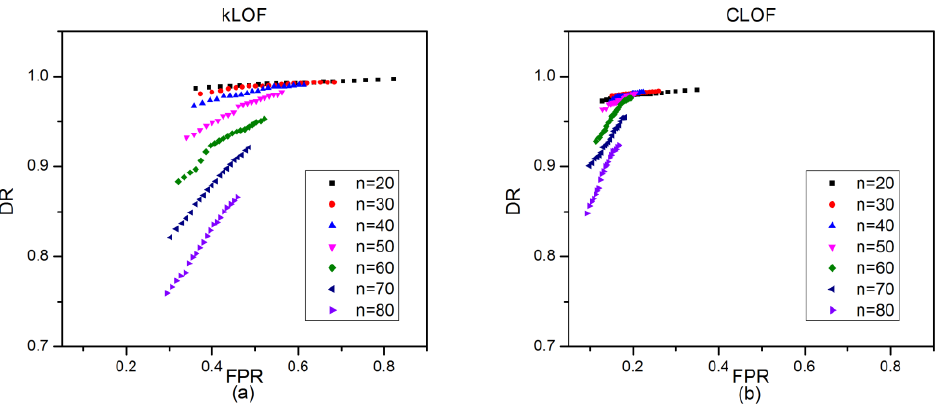
Figure 16. ROC curves of kLOF and CLOF methods on the Shuttle dataset with different n related to ( a ) the ROC curves of kLOF method; ( b ) the ROC curves of CLOF method.